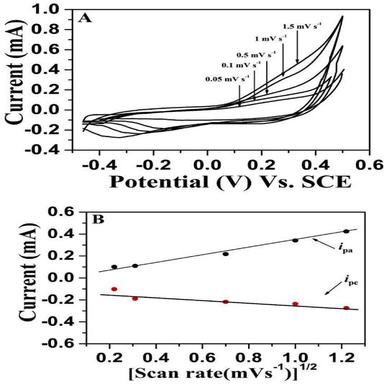
(A) Cyclic voltammograms of Na3MnCO3PO4 electrode recorded in 5 M NaNO3 aqueous electrolyte at various scan rate. (B) The relation between the peaks current and square root of scan rate.